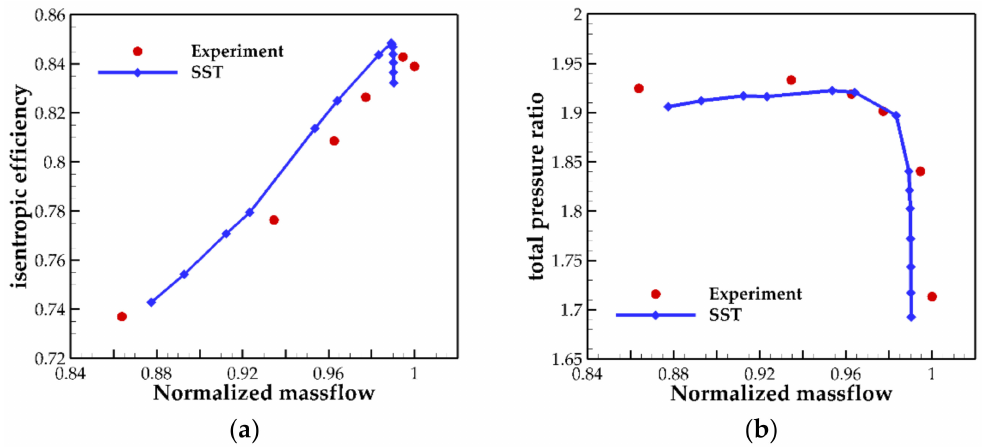
Figure 5. Performance comparison of the transonic compressor Stage 35. ( a ) Isentropic Efficiency. ( b ) Total Pressure Ratio.